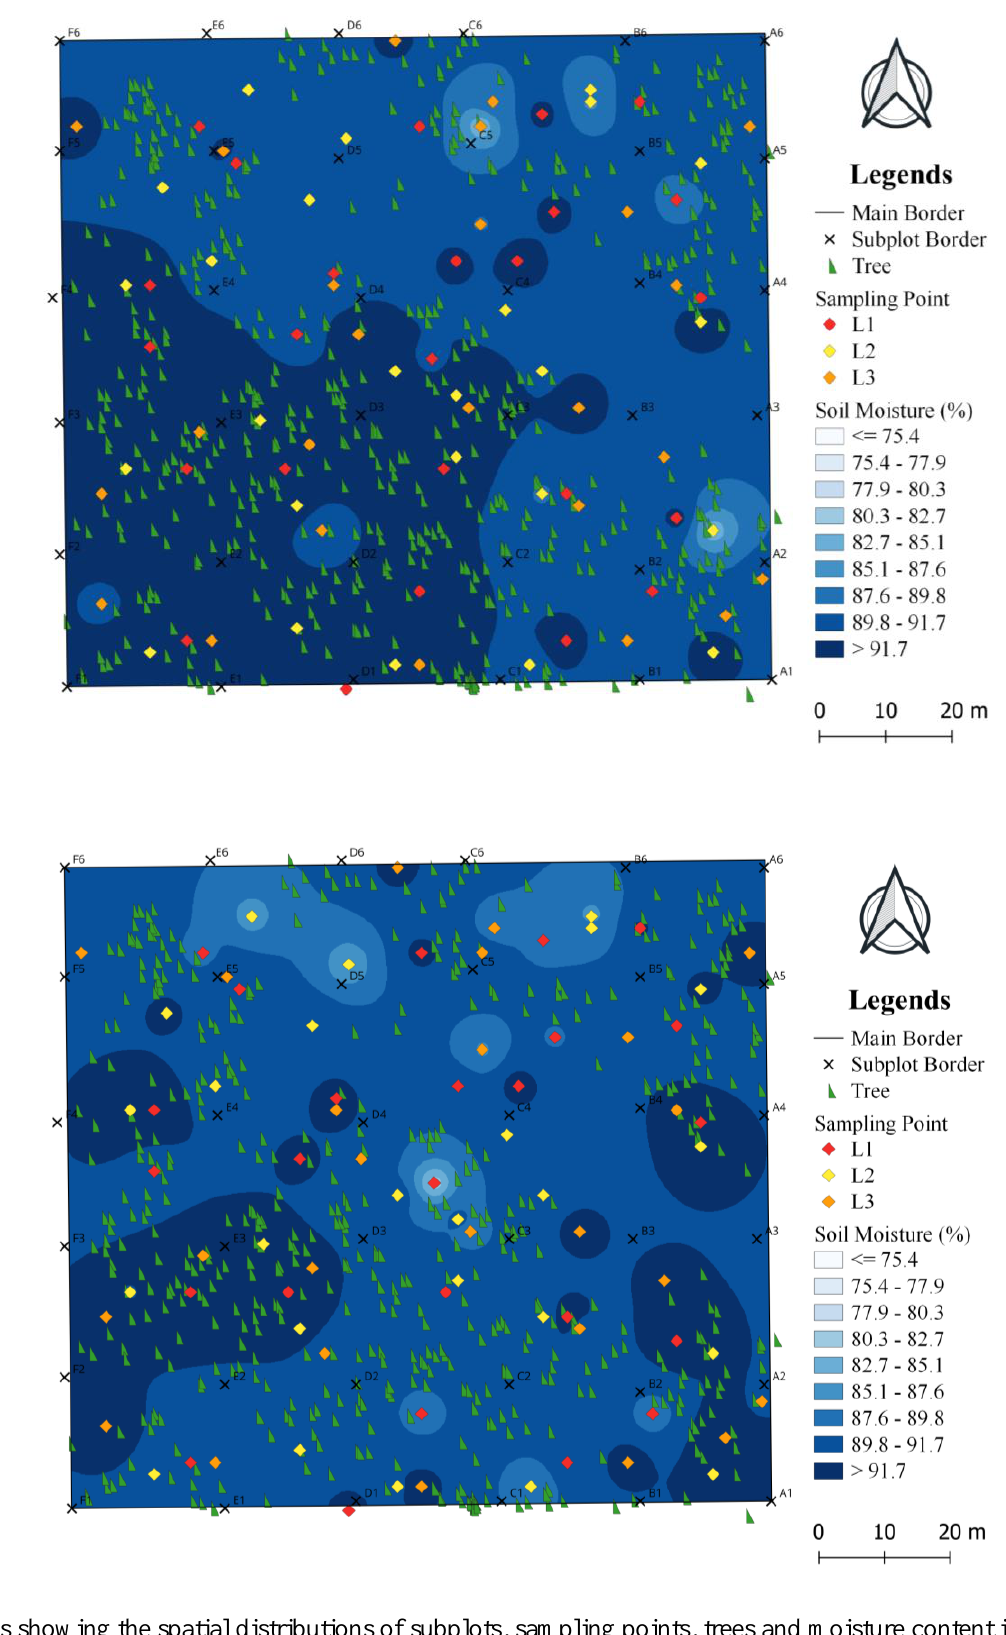
Figure 7. Maps showing the spatial distributions of subplots, sampling points, trees and moisture content in deeper (100–150 cm and 150–200 cm) soil layers at Sabaju secondary tropical peat swamp